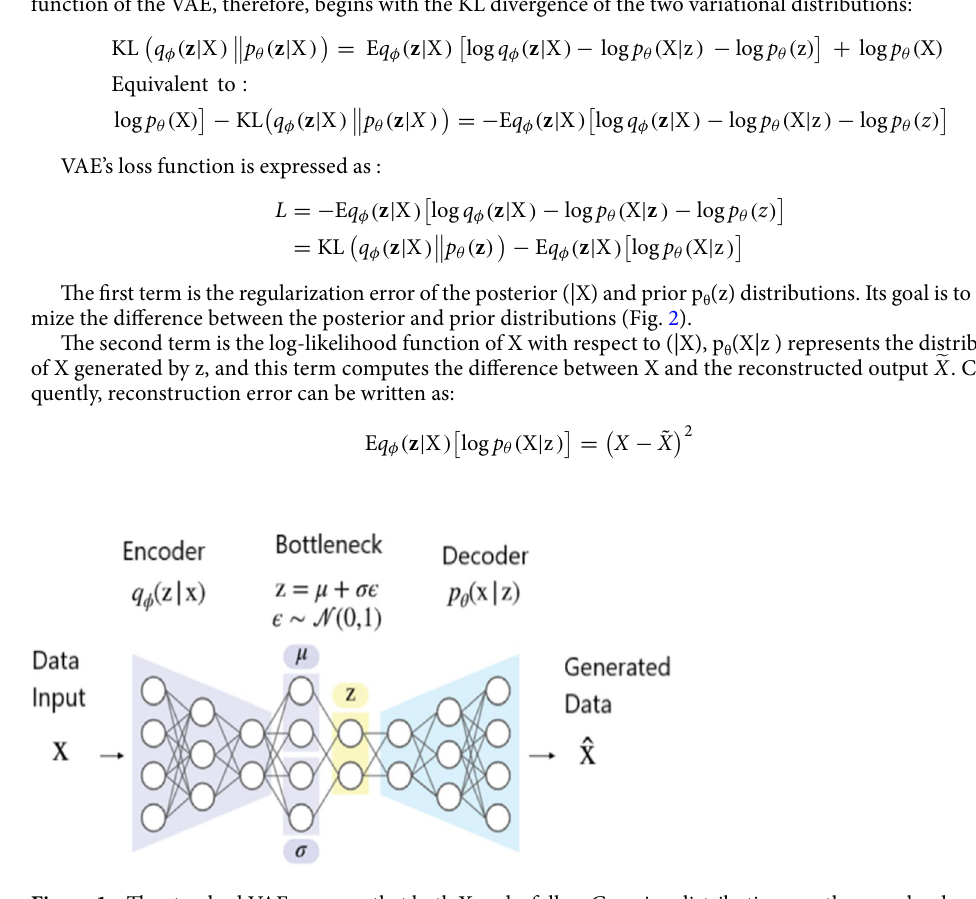
Figure 1. The standard VAE assumes that both X and z follow Gaussian distributions, so the encoder does not output z directly, but rather the distribution parameters of z, i.e. the mean and variance of the Gaussian distribution, and z is reconstructed using reparameterization. The decoder then outputs the mean of the Gaussian distribution with z as the input and fixes the